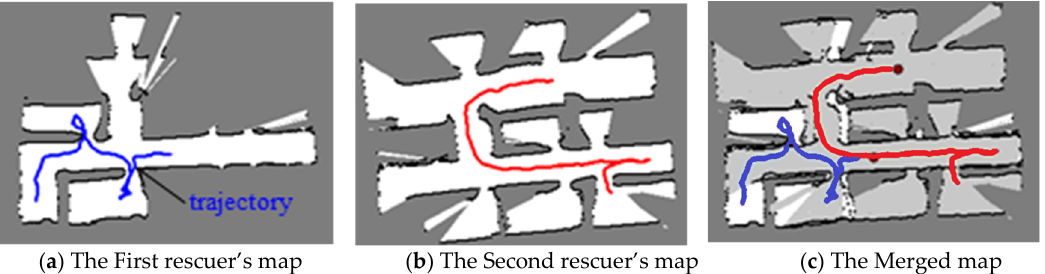
Figure 6. Results for the individual occupancy grid maps and the merged map (the routes of the first and second rescuers are represented by the blue and red lines, respectively).